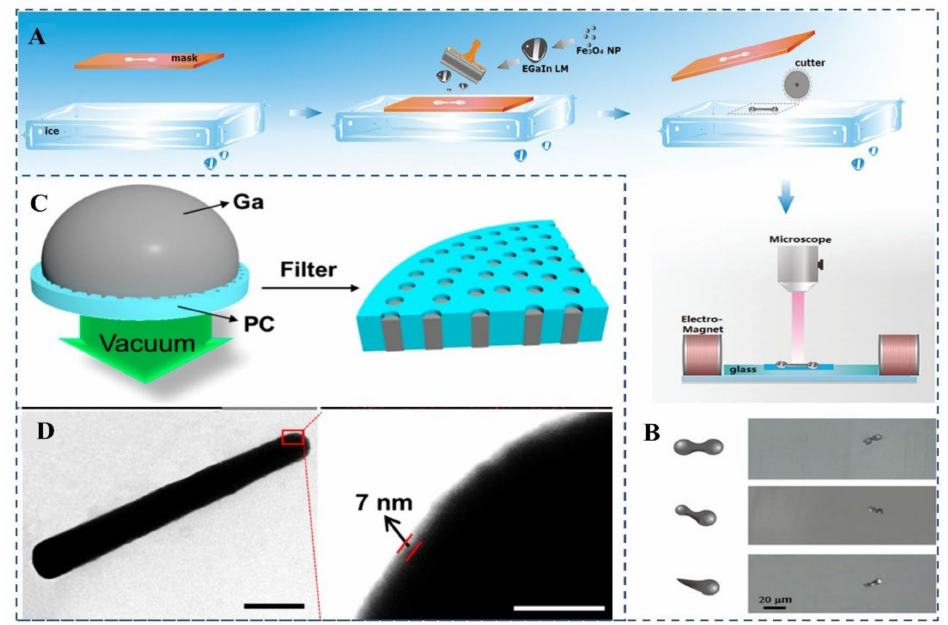
Figure 8. One-step fabrication methods for MLMTs. ( A ) Schematic illustration of the fabrication of MCLMTs through the ice-assisted transfer method [49]. ( B ) Microscopic images of the LM micro- motor in the dumbbell shape, in the bowling-pin shape, and the tadpole shape [49]. ( C ) Schematic illustration of the fabrication of MCLMTs through the pressure-filter-template method [9]. ( D ) TEM image shows the core-shell structure of MCLMTs through this method. Scale bar, 1 µ m. The enlarged TEM image indicates that a 7 mm oxide layer on the surface help stabilize the shape of motors. Scale bar, 50 nm